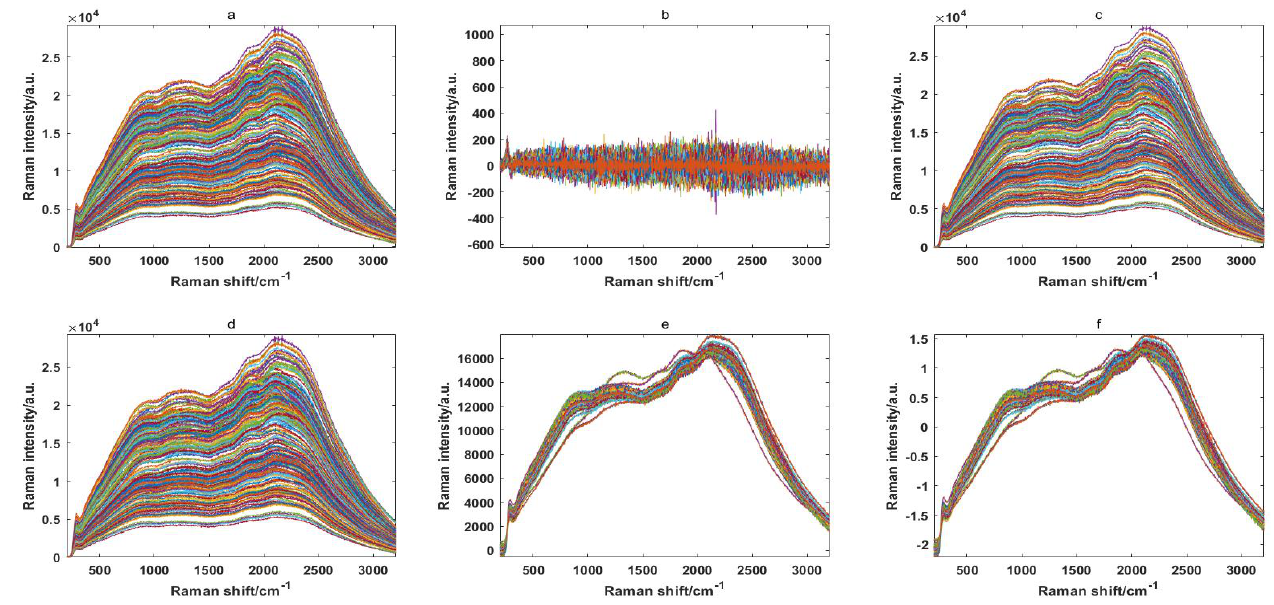
Figure 1. Original Ranman spectra ( a ) and Ranman spectra modified by removing the noise signal for 240 rice seed samples using Savitzky–Golay 1-Der ( b ), Savitzky–Golay smoothing ( c ), baseline ( d ), multivariable scatter correction ( e ) and standard normal variable ( f ).